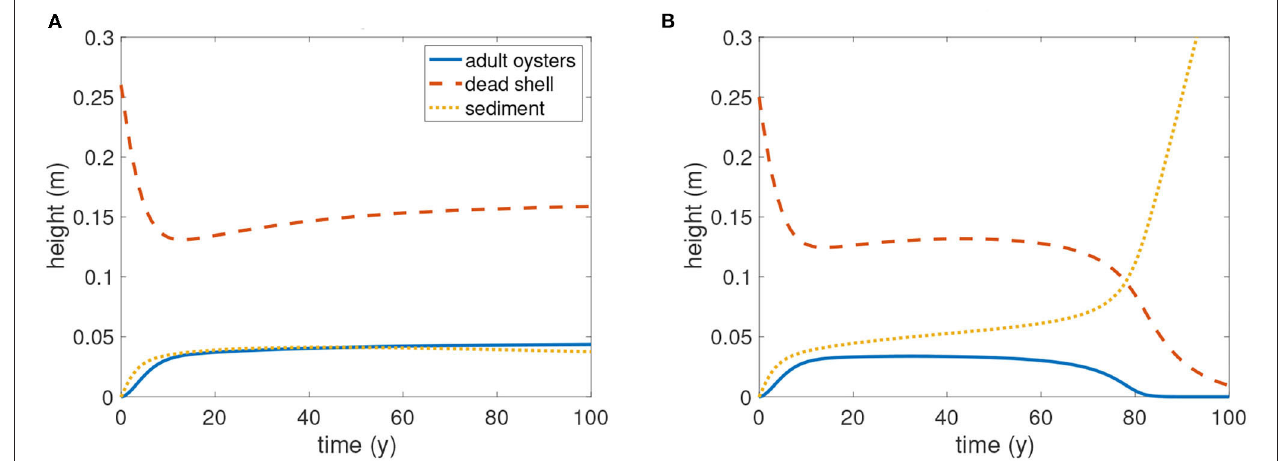
FIGURE 8 | Determination of threshold reef height R 0 with P = 250, as an illustration of the numerical approach used for a range of values of P . In this example, the time series of solutions is plotted with initial condition ( J , A , R , S ) = (0,0, R 0 ,0). (A) R 0 = 0.26, non-extinct outcome; (B) R 0 = 0.25, extinct outcome. The threshold reef height R 0 is therefore between 0.25 and 0.26. Blue: adult oysters; red: dead oyster shells; yellow: sediment. Here P = 250 and other parameters are as in Table 2 .